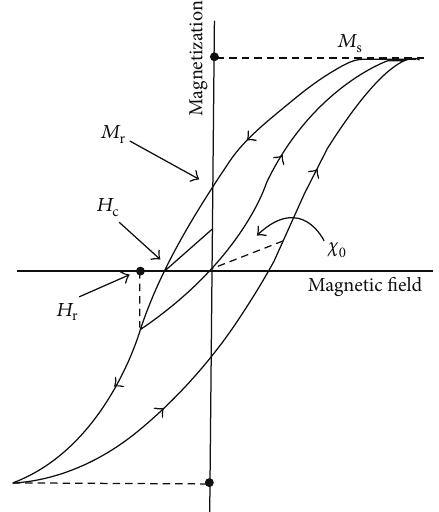
Figure 5: The magnetic hysteresis loop of ferromagnetic and ferrimagnetic materials. In this figure, several critical parameters ), remnant magnetization such as saturation magnetization ( 𝑀 s ), and coercive field ( 𝐻 ) can be ( 𝑀 r c